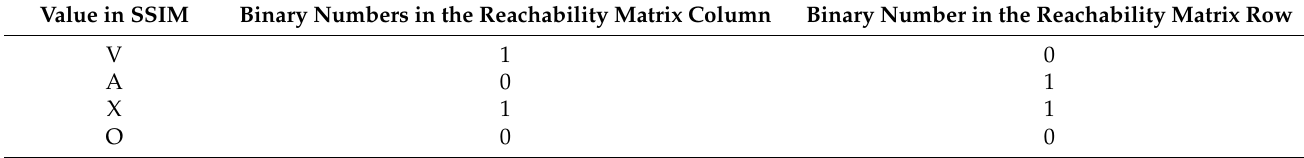
Table 2. Rules for Substituting